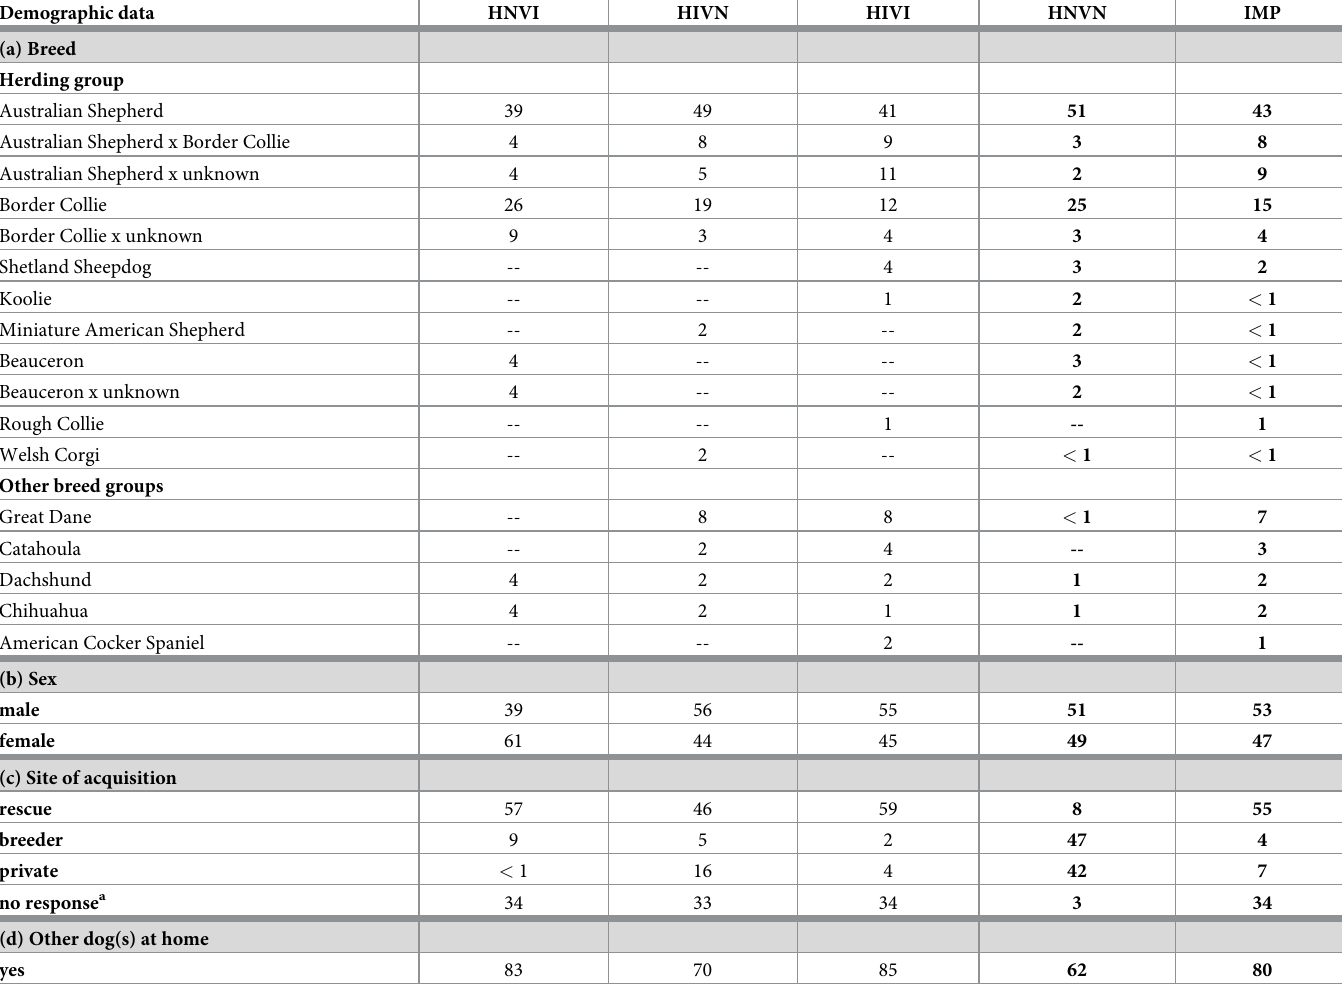
Table 3. Frequencies of responses, in percentages, obtained for each group and for the IMP cohort for the following demographic data: (a) breed, (b) sex, (c) site of acqui- sition, and (d) presence of other dog(s) at